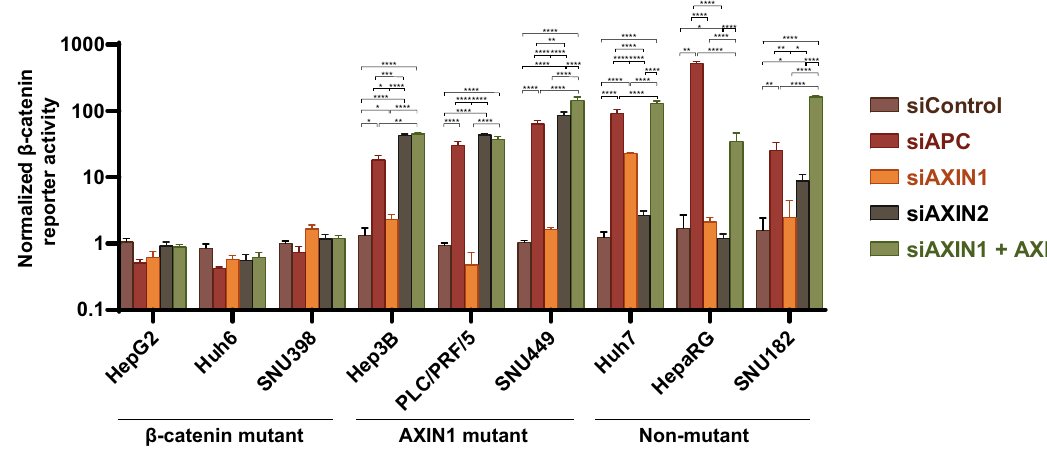
Figure 2. Both AXIN1 and AXIN2 contribute to β-catenin signaling regulation in HCC cell lines. All cell lines were subjected to a β-catenin reporter assay after siRNA-mediated knockdown of AXIN1 , AXIN2 , a combination thereof or APC . No significant changes in β-catenin reporter activity were observed in the CTNNB1-mutant lines. Among the AXIN1- mutant cells (Hep3B, PLC/PRF/5 and SNU449) both APC and AXIN2 knockdown are equally effective in enhancing signaling. AXIN1 or AXIN2 knockdown in the non-mutant lines (Huh7, HepaRG, SNU182) results in an incomplete increase in reporter activity when compared with APC knockdown, while combined AXIN1/AXIN2 knockdown is similarly effective. For this experiment the WRE/CMV-Renilla ratio for the control siRNA sample-1 was arbitrarily set to 1 for each cell line, after which all β-catenin reporter WRE/CMV-Renilla ratios for the samples were normalized to this control. Only significant differences are shown using an unpaired t-test (mean ± SD, n = 3, *P < 0.05; **P < 0.01; ***P < 0.001; ****P < 0.0001). Note the logarithmic Y-axis scale. The result shown here is one representative result, but comparable results were observed in two independent experiments performed on relevant lines (Supplemental Fig.